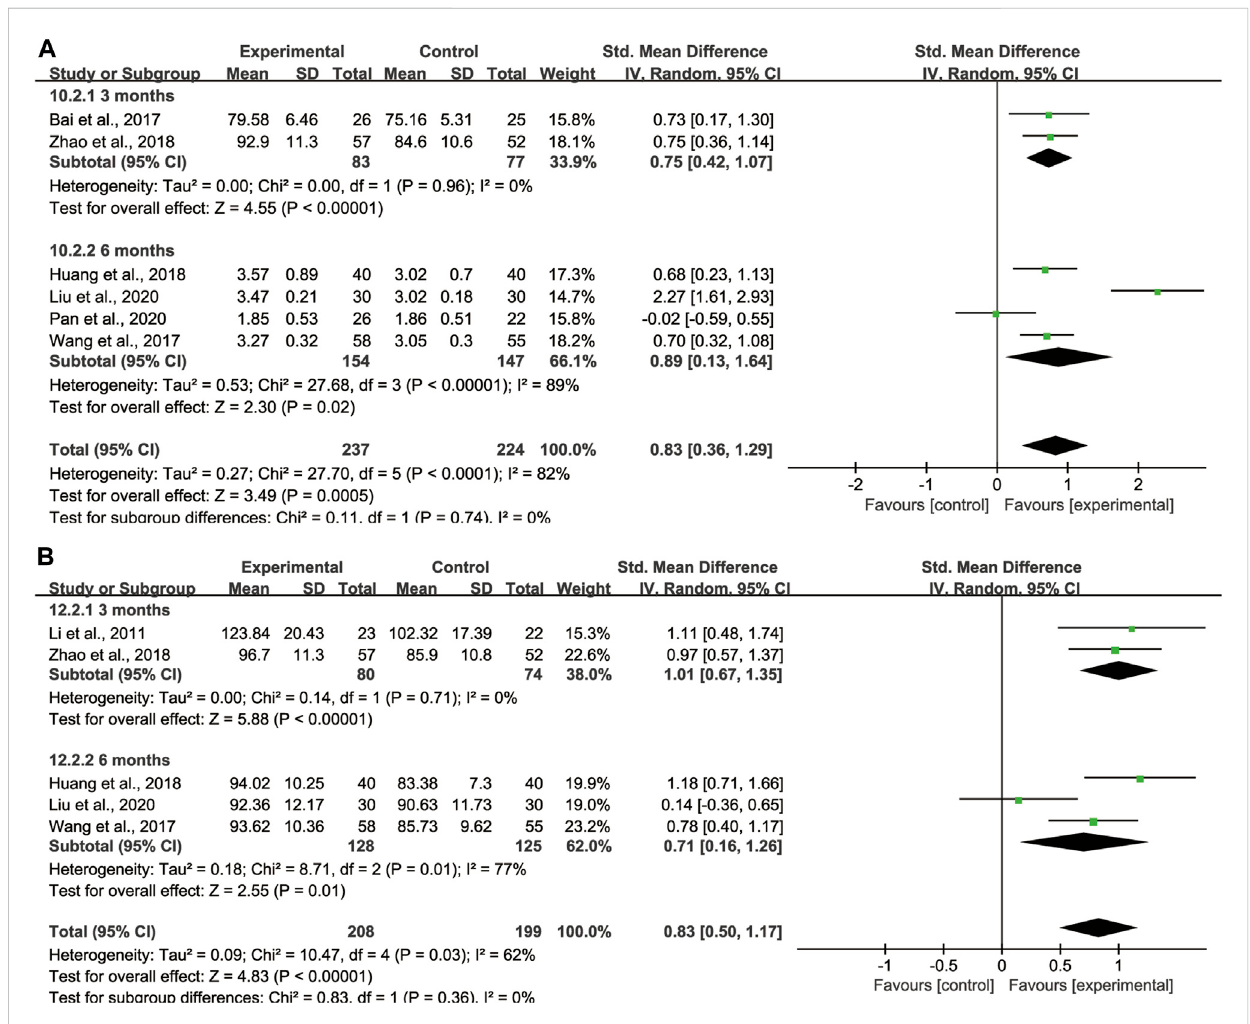
FIGURE 9 Subgroup analysis of lung function based on different treatment duration. (A) FVC, (B) MVV.